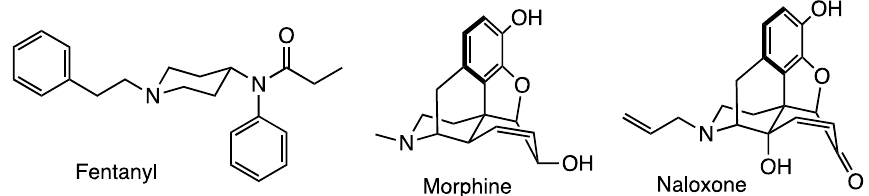
Figure 1. Structures of fentanyl, morphine and the most common antidote employed in cases of fentanyl poisoning,